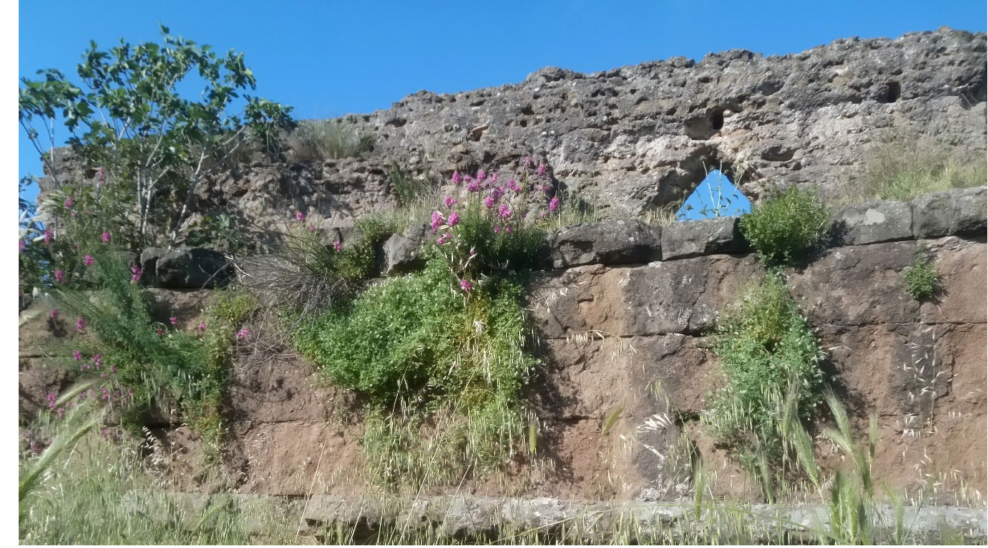
Figure 24. Cymbalario-Parietarietea diffusae on the ancient Roman Claudio aqueduct (Acque- dotti locality).